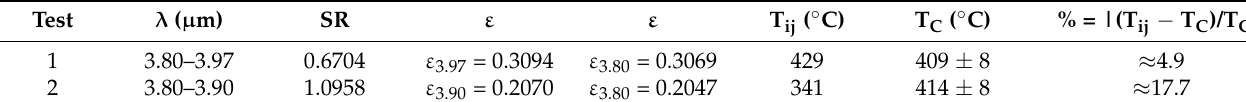
Table 1. Experimental test results column is referred, respectively, to the test number, central wavelengths of the filter couples, signal ratio values, emissivity for different filters, dual-color measurements (Tij), thermocouple measurements, and relative temperature accuracy of dual-color (Tc) with respect to the thermocouple measurements [5,6].